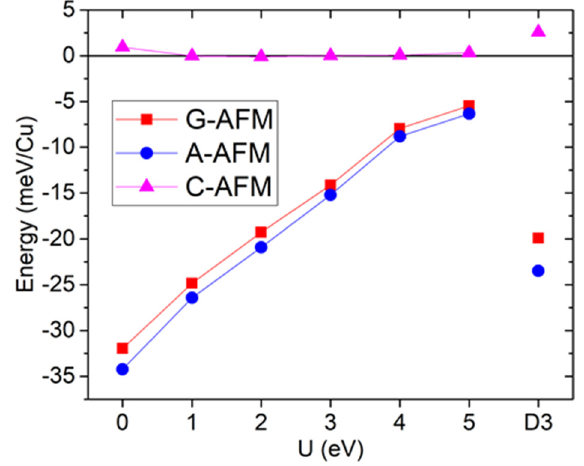
Figure 2. [Trz]Cu(H 2 POO) 3 GGA + U total energies, as a function of U, and GGA + D3(BJ) total energies, relative to the ferromagnetic state.